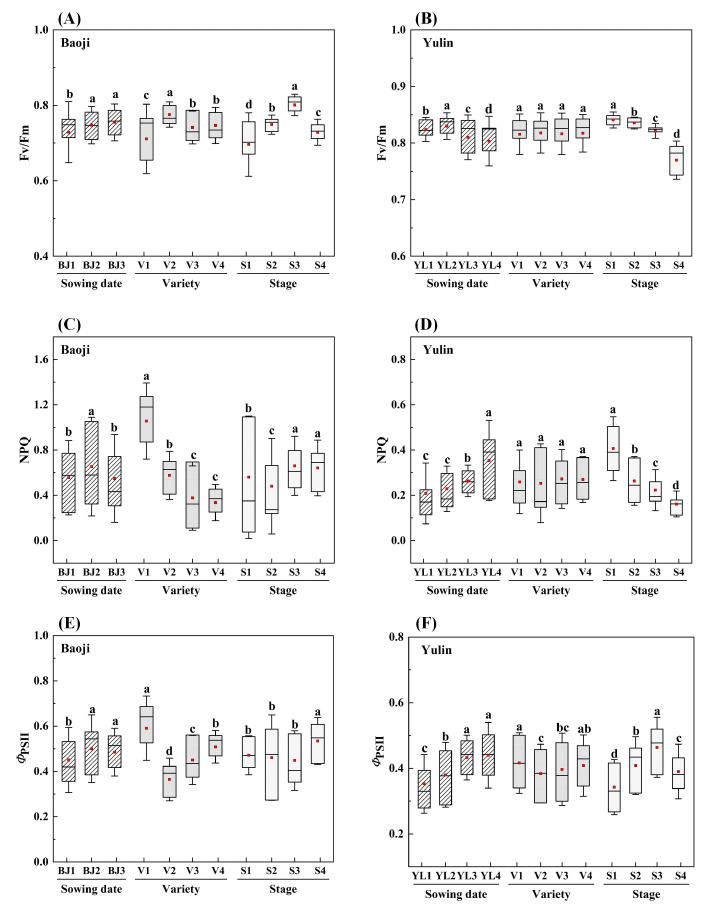
Figure 3. The overall difference in leaf chlorophyll fluorescence characteristics of broomcorn millet in Baoji ( Fv / Fm , NPQ and Φ PSII , ( A , C , E ), respectively) and Yulin ( Fv / Fm , NPQ and Φ PSII , ( B , D , F ), respectively). The different lowercases represent the significant differences among treatments in each group at the two